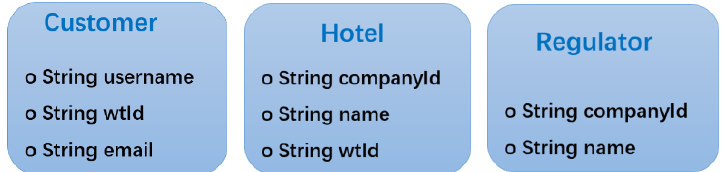
Figure 14. Participant definition in Hyperledger Fabric smart contract.